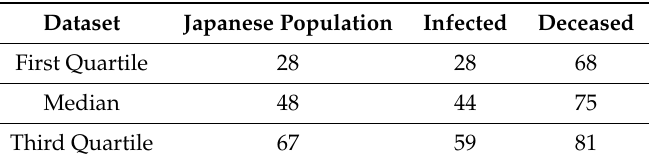
Table 2. Statistical summary of the data from Table